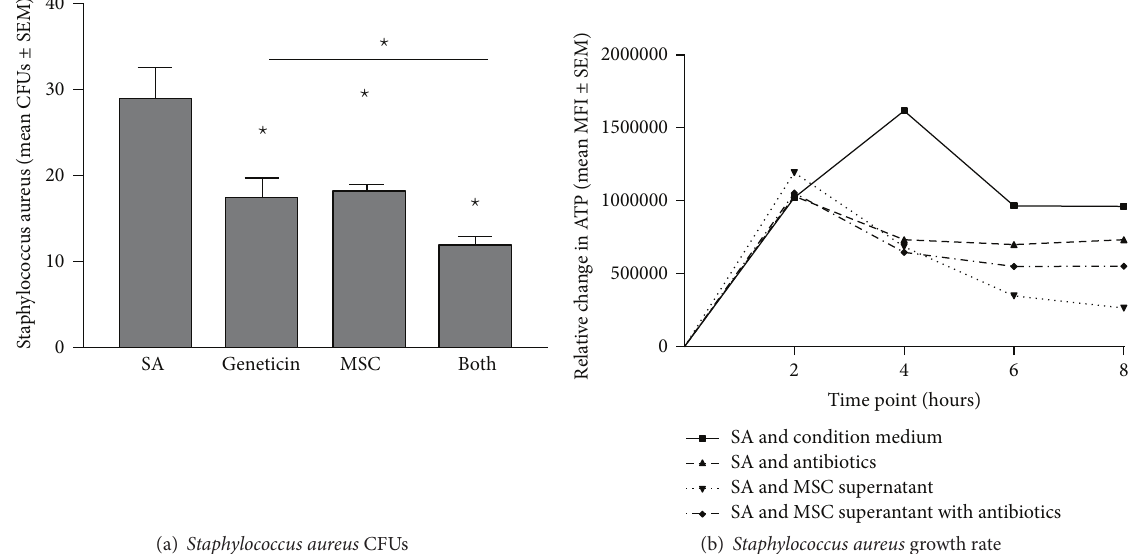
Figure 3: MSCs and their products alter Staphylococcus aureus growth. Bone marrow derived hMSCs supernatants were cultured with different dosages of Staphylococcus aureus with and without the addition of geneticin (100 𝜇 g/mL). Aliquots of the bacteria were streaked onto TSA plates for CFUs (a) or evaluated for ATP production (b). hMSC supernatants ( 𝑛 = 8 different donors) significantly decreased both Staphylococcus aureus CFUs ( 𝑃 ≤ 0.05 ) and growth kinetics ( 𝑃 ≤ 0.05 ). Geneticin was used as a positive control which also significantly decreases both CFUs ( 𝑃 ≤ 0.05 ) and growth rate ( 𝑃 ≤ 0.05 ) which was enhanced by the addition of hMSCs ( 𝑃 ≤ 0.05 versus antibiotic alone for both CFUs and growth rate). SA = Staphylococcus aureus growth without treatment. Geneticin = treatment with the antibiotic geneticin, +hMSCs = treatment with hMSC derived supernatant, and Both = treatment with both hMSC supernatants and geneticin.